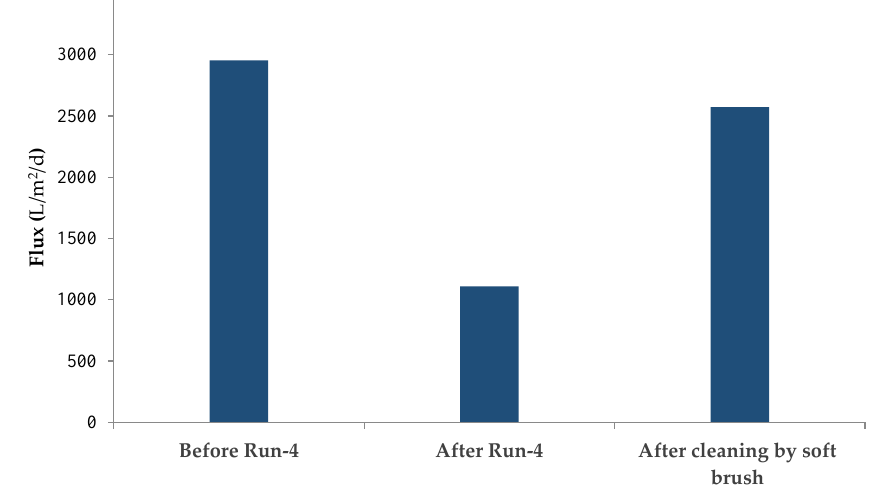
Figure 7. Recovery of pure water filtration flux by simple washing using soft brush in Run-4 at 4.5 kPa.